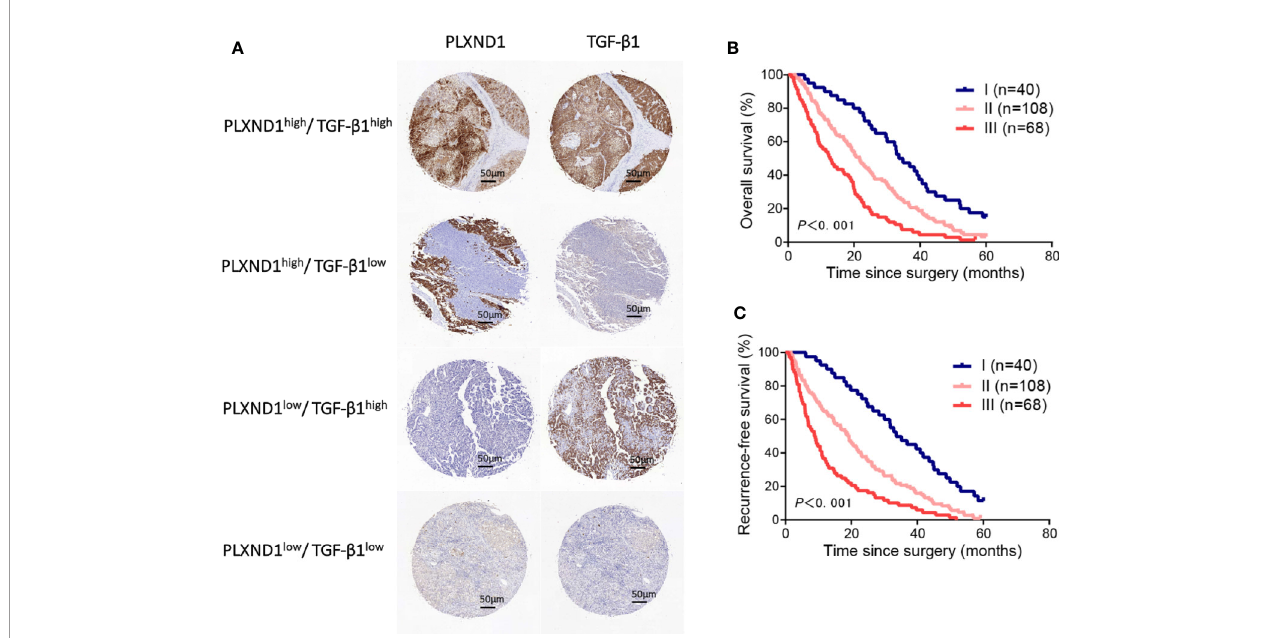
FIGURE 4 | The prognostic value of PLXND1 and TGF- b 1 in patients with hepatocellular carcinoma (HCC). Patient tumor tissues were immunostained for PLXND1 or TGF- b 1 and classi fi ed into three groups: group I, double negative (PLXND1 low /TGF- b 1 low ); group II, PLXND1 high /TGF- b 1 low and PLXND1 low /TGF- b 1 high ; and group III, double positive (PLXND1 high /TGF- b 1 high ). (A) Representative immunohistochemical staining characteristics of PLXND1 and TGF- b 1 expression in each patient group. (B, C) Kaplan-Meier analysis of overall survival (OS) and recurrence-free survival (RFS) based on the expression of PLXND1 and TGF- b 1 showed that the combination of PLXND1 high and TGF- b 1 high indicated a worse clinical outcome for patients with HCC. High expression: the score was 2 or 3; low expression: the score was 1 or